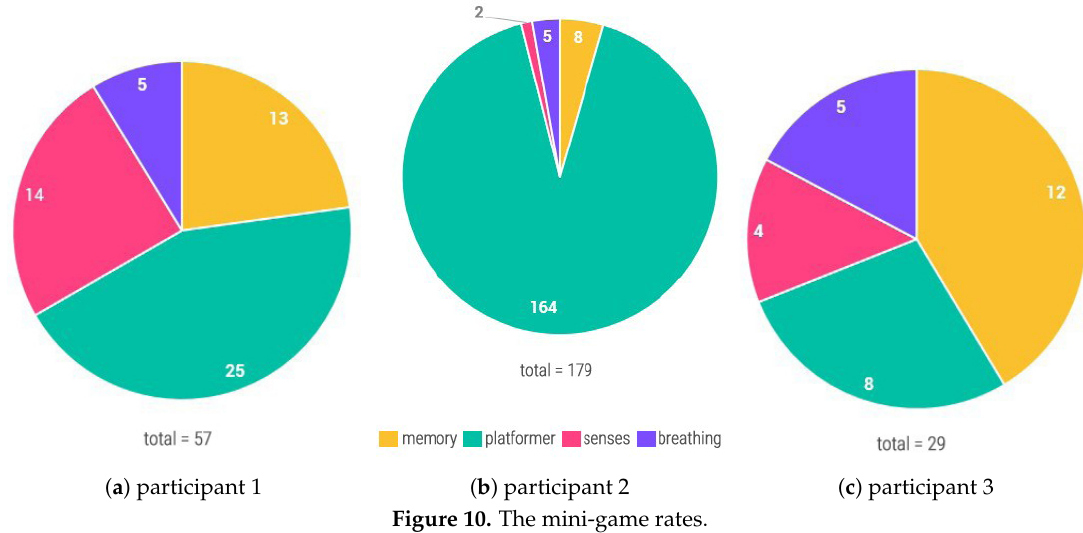
Figure 10. The mini-game